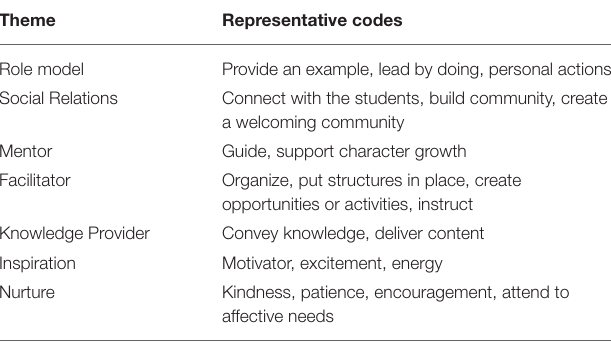
TABLE 2 | Themes and representative codes for the role of a teacher.